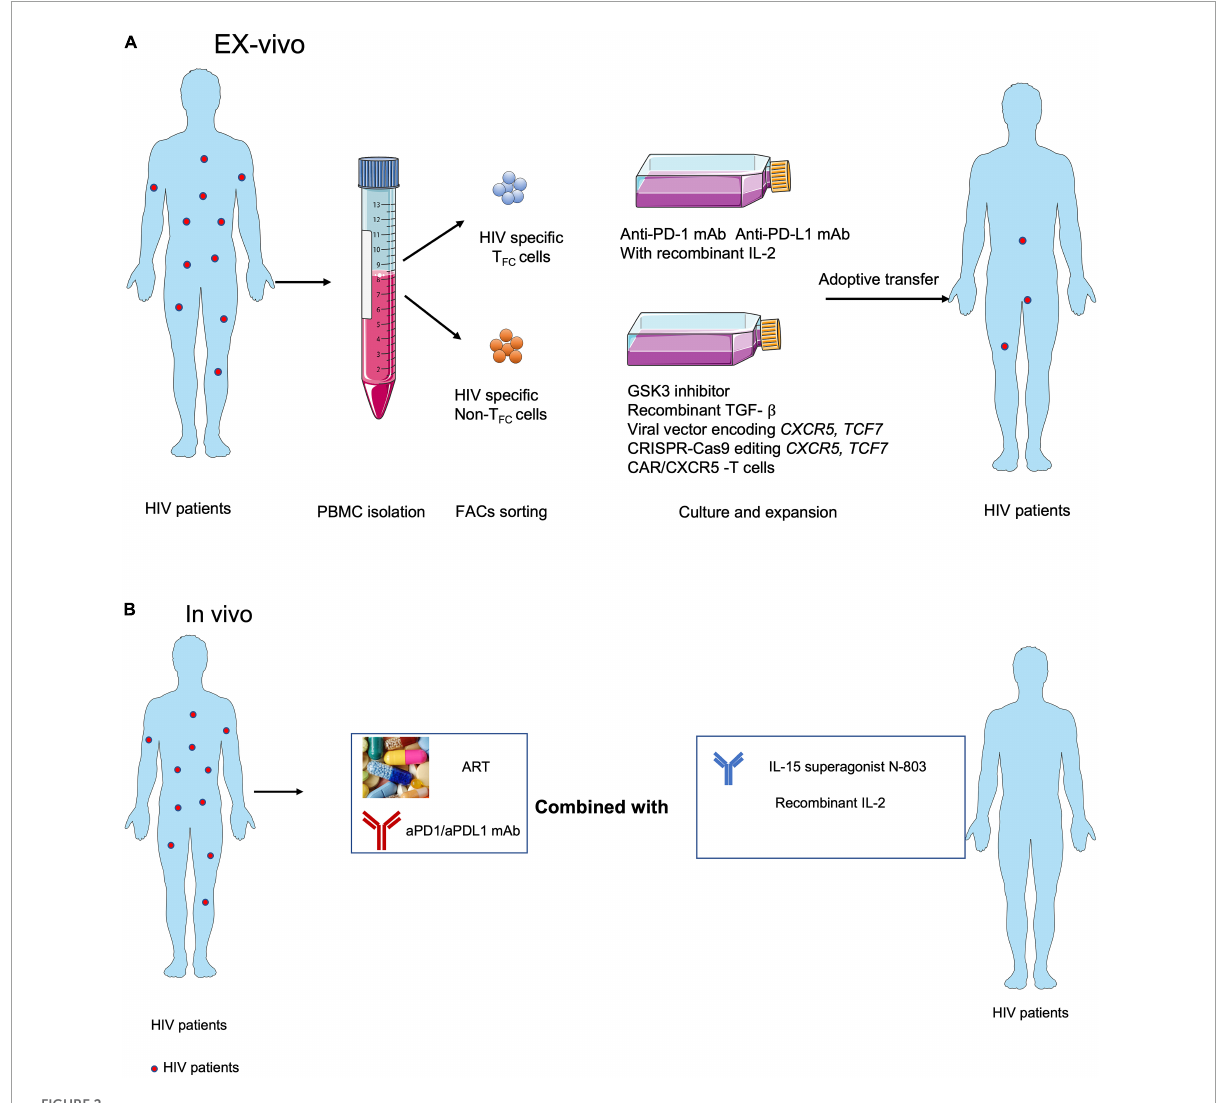
FIGURE2 Strategies for targeting CXCR5 + CD8 + T cells in immunotherapies against HIV infection. (A) Adoptive transfer of ex vivo expanded endogenous CXCR5 + CD8 + T cells with anti-PD-1 or anti-PD-L1 blocking antibodies or CXCR5 + CD8 + T cell-promoting cytokines, e.g., IL-15 super agonist (Miller et al., 2022), recombinant IL-2 (Codarri Deak et al., 2022; Perdomo-Celis et al., 2022), GSK3 inhibitor (Perdomo-Celis et al., 2022), recombinant TGF- ß (Ogunshola et al., 2022), overexpressed CXCR5 (Ayala et al., 2017) and TCF1 (Rutishauser et al., 2021) and using the CXCR5 expressed CAR-T (Pampusch et al., 2022). (B) ART with anti-PD-1 or anti-PDL1 blocking antibodies combined with CXCR5 + CD8 + T cell-promoting cytokines, e.g., IL-15 super agonist (Miller et al., 2022) and IL-2 (Codarri Deak et al., 2022; Perdomo-Celis et al., 2022) in vivo